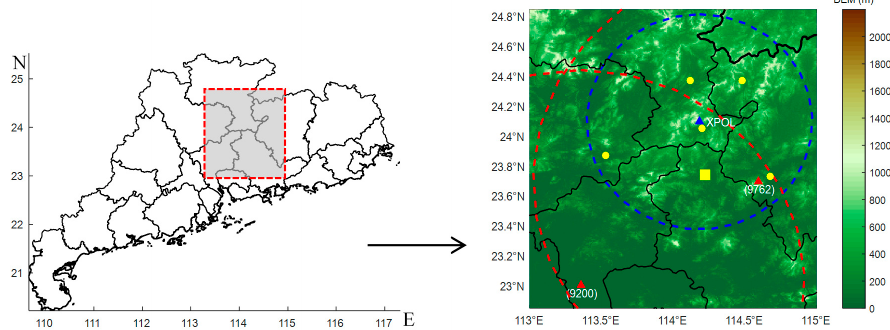
Figure 1. Layout of the X-band dual-polarization radar (XPRAD), two S-band radars and national meteorological station. The blue triangle represents the location of XPRAD, blue dash circle line indicates that the detection range of XPRAD is 80 km. The red triangle represents the locations of two S-band Doppler radars (9200 and 9762), red dash circle line indicates that the detection range of the two radars is 150 km. The yellow circle dot indicates the rain gauges which are deployed at the national meteorological station. The yellow square represents the location of one autonomous parsivel unit (APU) and one rain gauge which are deployed at the Longmen national meteorological station.